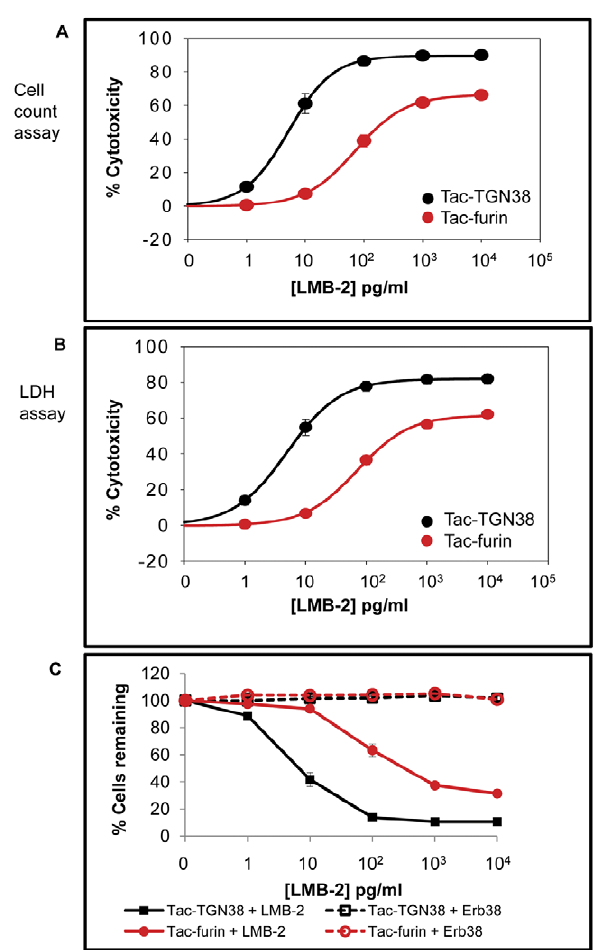
Figure 2. Comparison of cytotoxic effects and immunotoxin specificity in Tac-receptor expressing cells. Tac-TGN38 and Tac- furin cells were treated with up to 10 ng/ml of LMB-2. After a 24 hour incubation with immunotoxin, cells were washed and the cells remaining in the well were used for A ) Hoechst-based cell count assay or B ) LDH assay as described in Methods. Panels A and B show % cytotoxicity plotted against the concentration of LMB-2. The data points represent the cytotoxicity values averaged over several experiments, cell count assay (n=9), LDH assay (n=8). The standard error of the mean is shown. C ) Tac-TGN38 and Tac-furin cells were seeded and then treated with up to 10 ng/ml of LMB-2 or Erb38 one day after plating. After a 24 hour incubation with immunotoxin, cytotoxicity was assessed by a cell count assay. The number of cells remaining after toxin treatment is shown as a fraction of cells incubated without toxin (n=5). The standard error of the mean is shown.